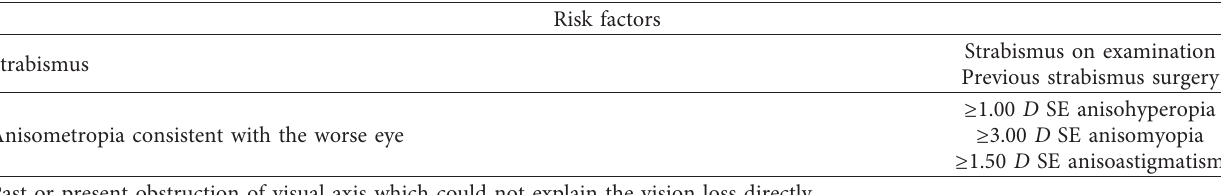
Table 1: Risk factors of amblyopia definition.